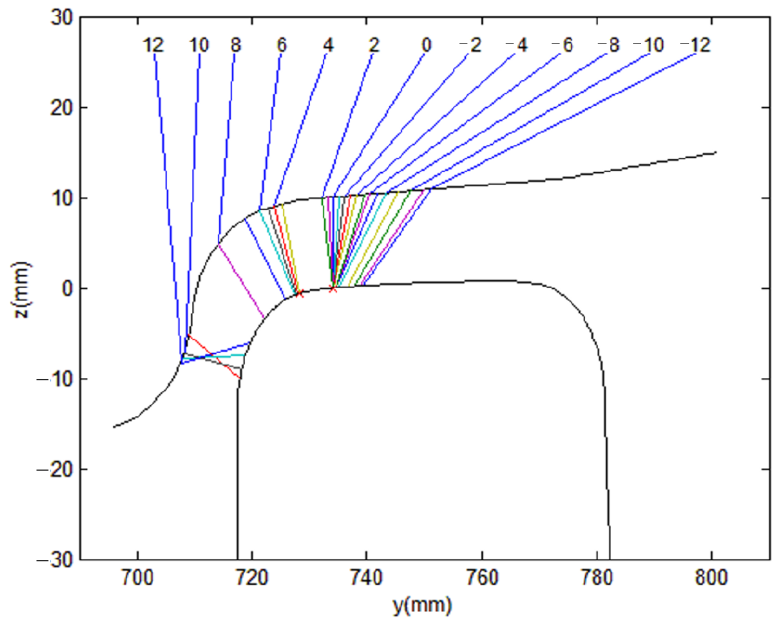
Figure 9. Position of contact points on wheel and rail depending on lateral displacement of wheelset (wear-optimized wheel profile).